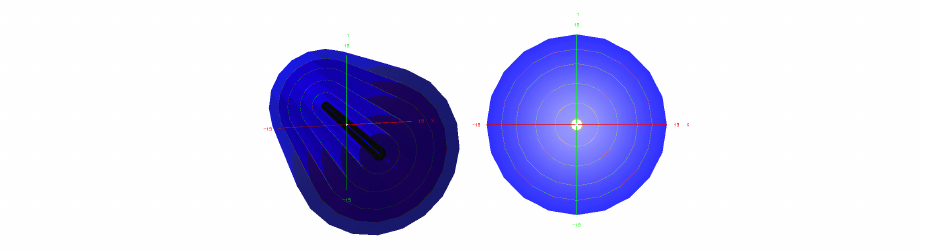
Figure 3. Silicon-strips Inner Tracker, described in the DD4HEP simulation.